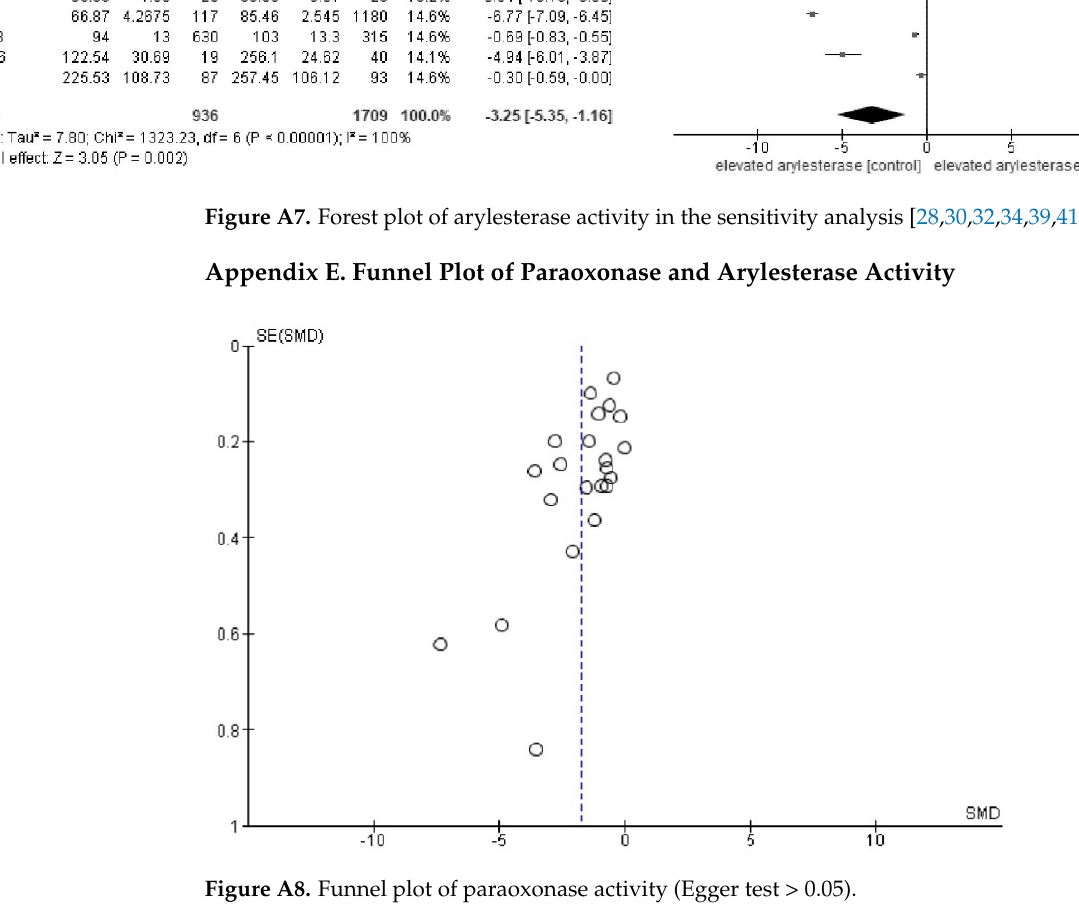
Figure A8. Funnel plot of paraoxonase activity (Egger test > 0.05).